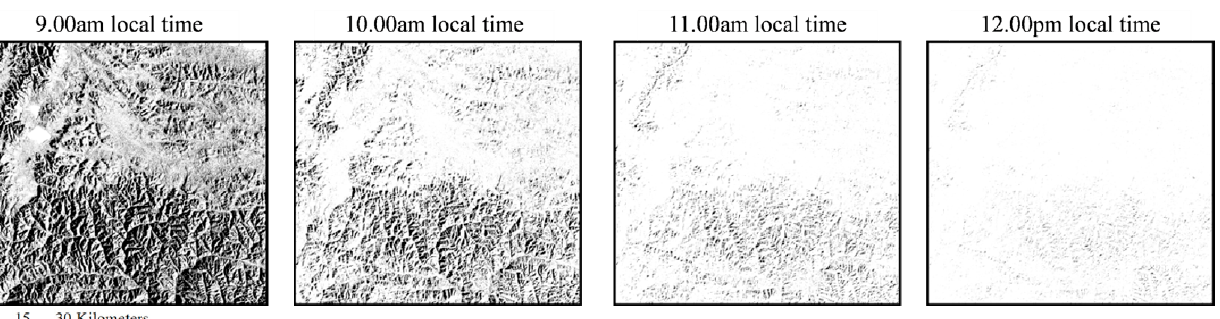
Figure 8. Shadow Binary Factor evolution over day time (shadowed pixels in black and illuminated pixels in